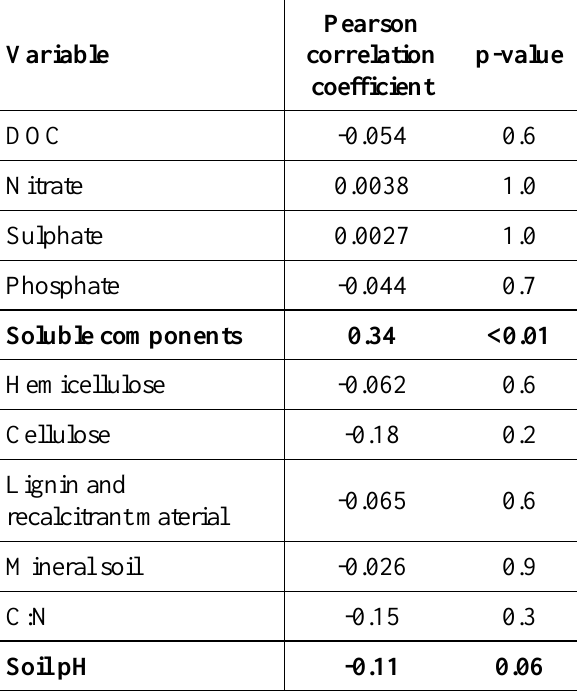
Table 5. Correlations of methane (CH biochemical parameters across the shallow cores from all sites. Values in bold indicate a significant or marginally significant correlation with CH